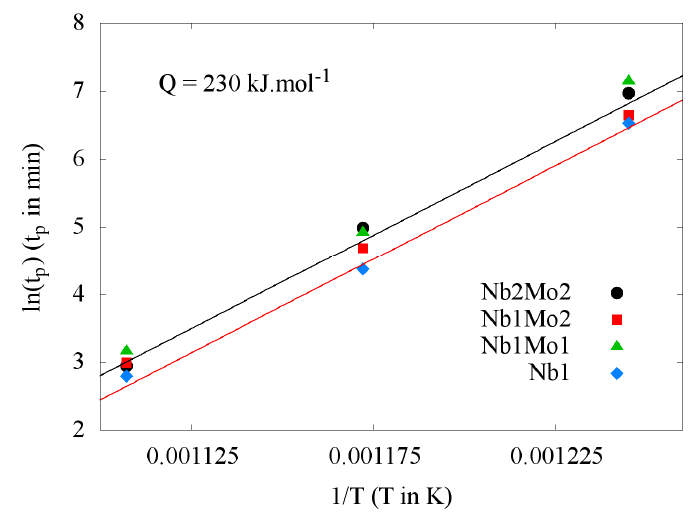
Figure 10. Arrhenius plot of the peak aging times.